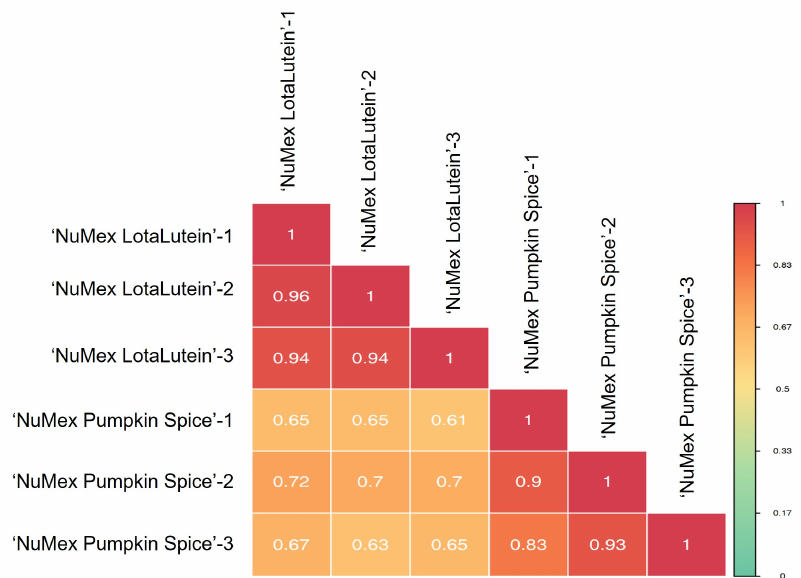
Figure 4. Pearson correlation coefficients among the biological replicates for the cultivars. Numbers 1, 2, and 3 correspond to the first, second, and third biological replications, respectively. Correlation coefficients were significant at p < 0.0001. Table 1. Top 10 most highly upregulated and downregulated